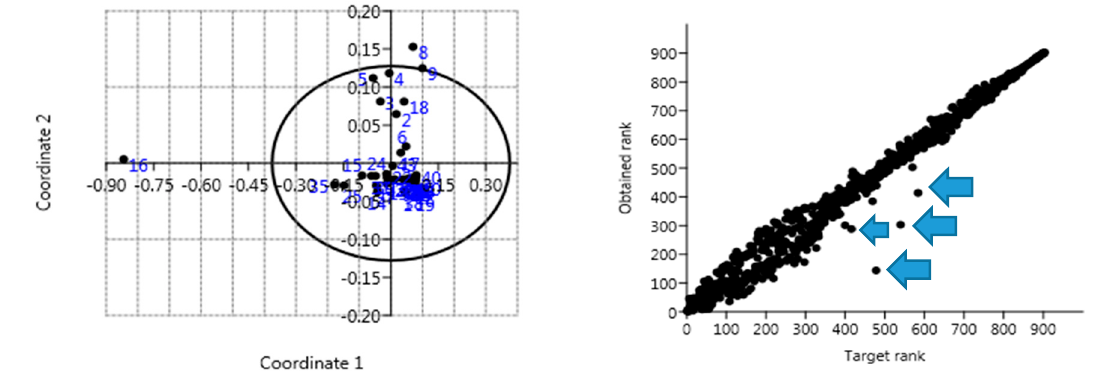
Figure 5. NMDS scatter plot ( left ) and Shepard 2-D plot ( right ) of different water sampling points along the Syr Darya River in Kazakhstan on the basis of water parameters employing Euclidean as a similarity measure.